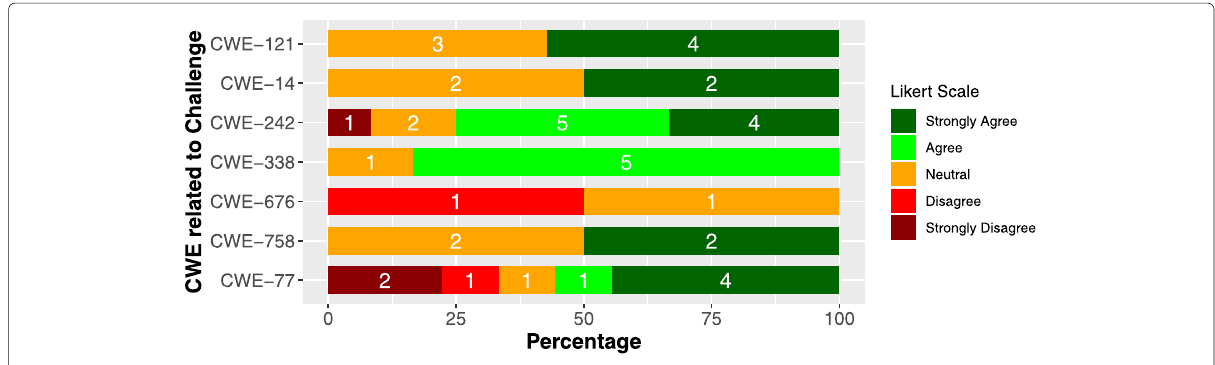
Fig. 14 Evaluation of Challenges in Sifu Platform - Survey S 1 ,